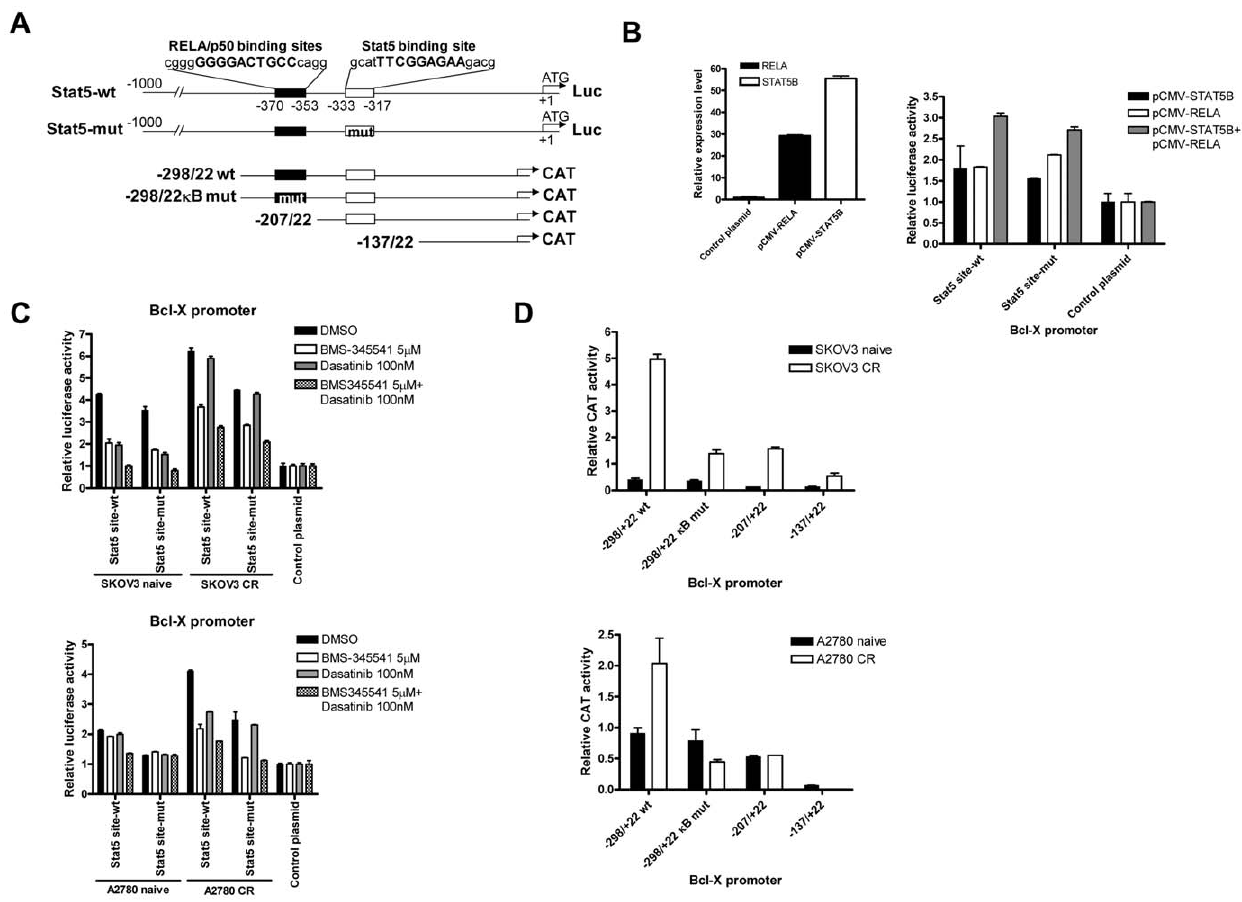
Figure 3. Co-induction of RELA and STAT5 in chemoresistant cells results in upregulated Bcl-xL transcription. A) Schematic illustration of the six Bcl-X reporter constructs used in this study. The name of CAT constructs reflects their length relative to the first nucleotide in the Bcl-xL cDNA. STAT5-mut contains a point mutation in the Stat5 consensus binding site, while -298/22 k B mut has three base substitutions in the RELA/p50 consensus binding site. B) Bcl-X promoter assay using 293T cells transfected with STAT5-wt or STAT5-mut or control reporter plasmid, plus pCMV- RELA and/or pCMV-STAT5B. Luciferase activity was measured 24 hours after transfection (right panel); exogenous RELA and STAT5B expression level at 24 hours after transfection of pCMV-RELA or pCMV-STAT5B or control plasmid (left panel). C) Bcl-X reporter assay in chemoresistant cells and their naı¨ve counterparts transfected with STAT5-wt or STAT5-mut or control reporter plasmid (top panel: SKOV3; bottom panel: A2780). Luciferase activity was measured 24 hours after treatment with 5 m M BMS-345541 and/or 100 nM dasatinib and/or DMSO. D) CAT ELISA assay of chemoresistant cells and their naı¨ve counterparts. CAT activity was measured 48 hours after transfection with the CAT-reporter plasmids (top panel: SKOV3; bottom panel: A2780)